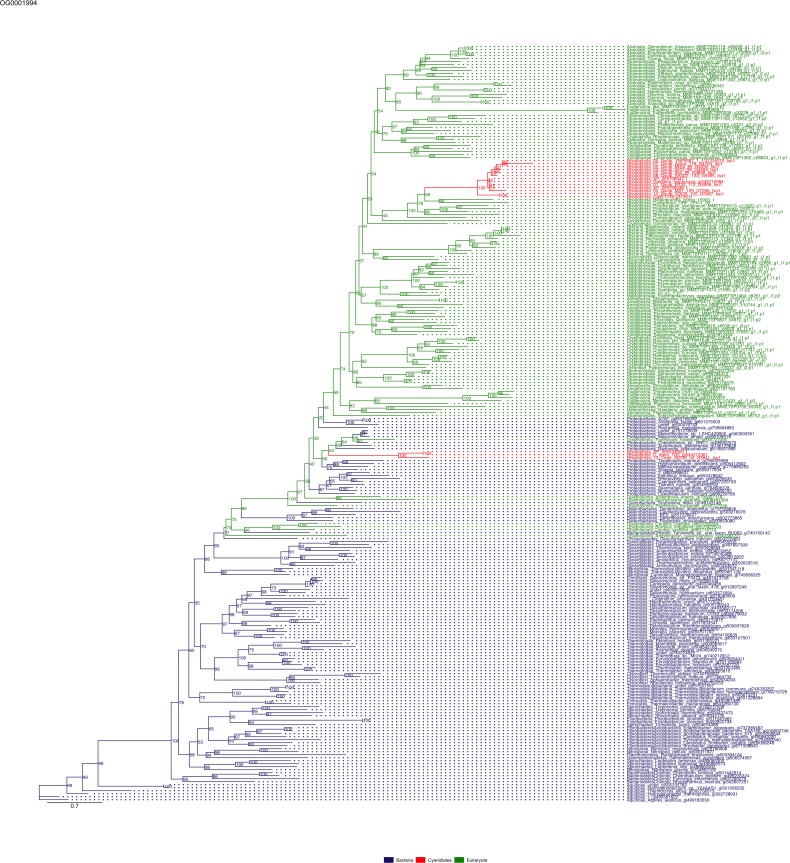
Sequence tree of orthogroup OG0001994.The tree is based on amino acid sequences. Archaea (yellow), Bacteria (blue), Cyanidiales (red), Eukaryotes including other red algae (green). Branches containing Cyanidiales sequences are highlited in red.